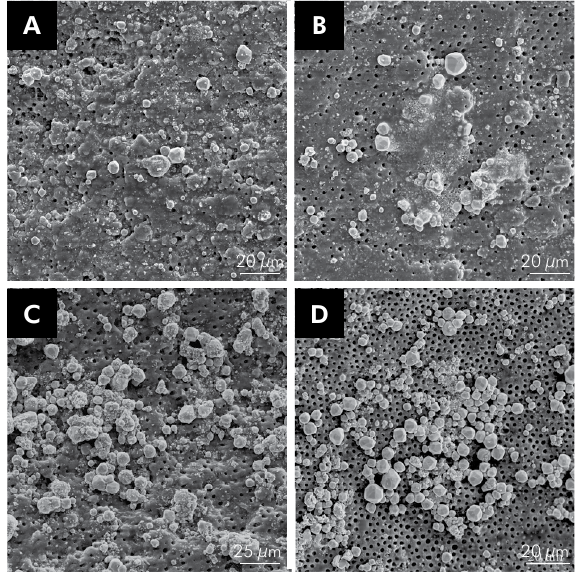
Figure 2. Representative image of the open dentinal tubules (A) G1 (E-I-AE), 95% ethanol and immediate acid etching; (B) G2 (X-I-AE), xylol and immediate acid etching; (C) G3 (E-D-AE), 95% ethanol and etching 7 days later; and (D) G4 (X-D-AE), xylol and acid etching after 7